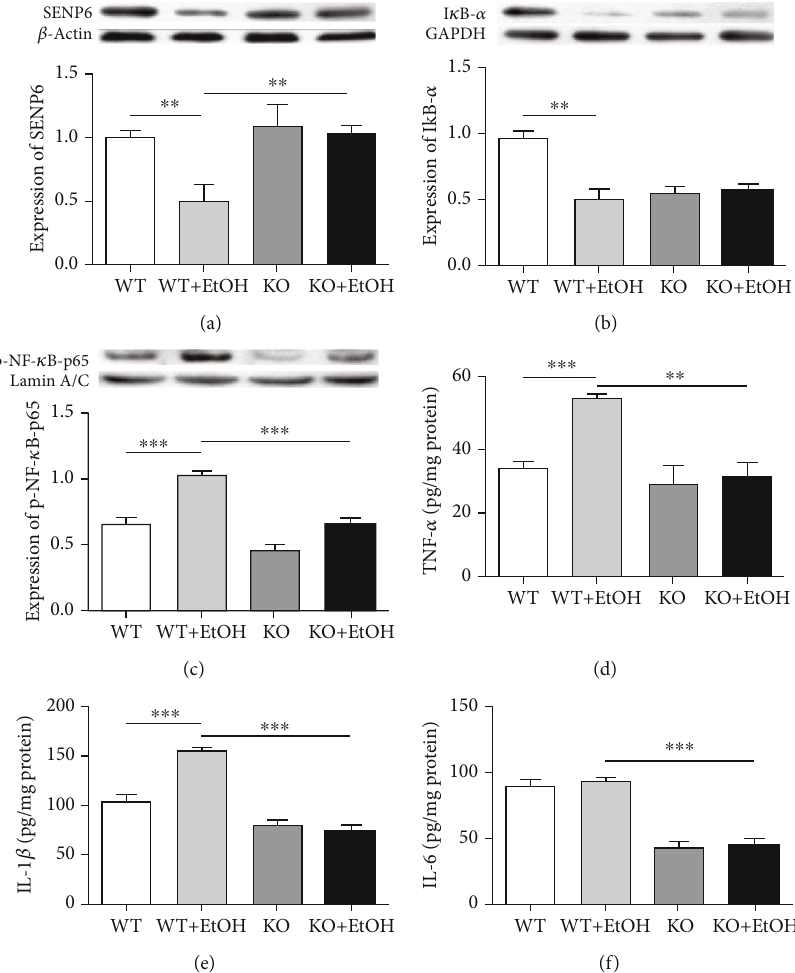
Figure 4: E ff ects of ethanol exposure on the levels of SENP6, IkB- α , p-NF- κ B-p65, and proin fl ammatory cytokines in the hippocampus. The hippocampal levels of SENP6 (a), IkB- α (b), and p-NF- κ B-p65 (c) of the WT, WT+EtOH, KO, and KO+EtOH rats were measured by WB. And the levels of TNF- α (d), IL-1 β (e), and IL-6 (f) proteins were measured by ELISA. WT =control rats without ethanol; WT +EtOH=control rats with ethanol; KO=TLR4 knockout rats without ethanol; KO+EtOH=TLR4 knockout rats with ethanol. Quantitative analyses were normalized to β -actin (for SENP6), GADPH (for IkB- α ), or Lamin A/C (for p-NF- κ B-p65) for WB. Cytokine concentrations were normalized to the total protein content. Data are presented as the mean ± S : E : M . ∗∗ p < 0 : 01 , ∗∗∗ p < 0 : 001